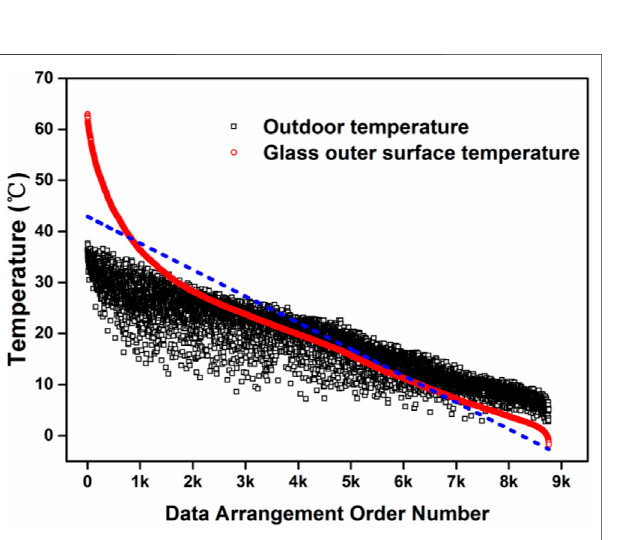
Frontiers in Materials |